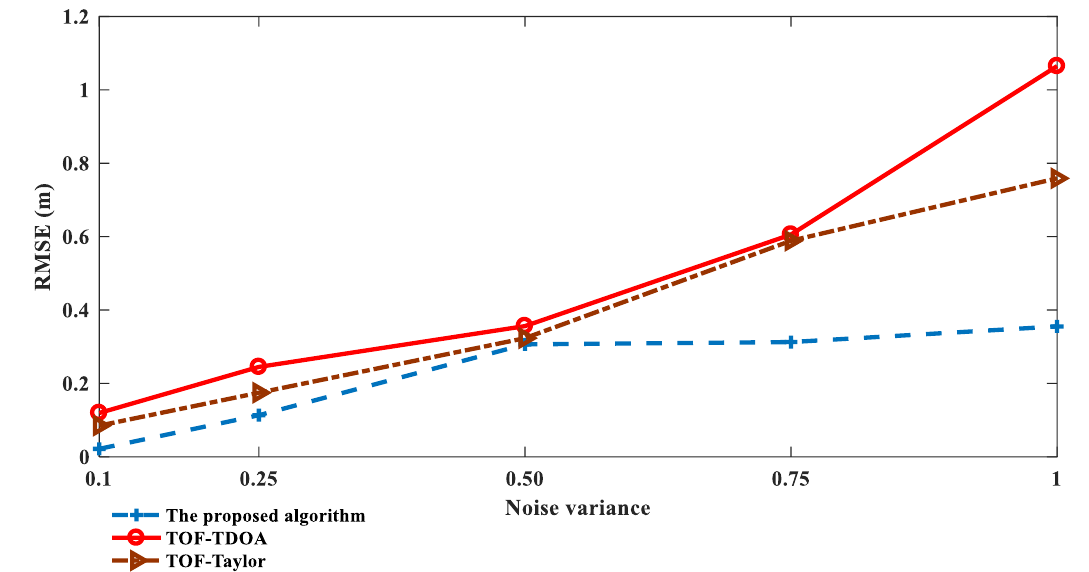
Figure 4. Positioning performance under different noise levels.